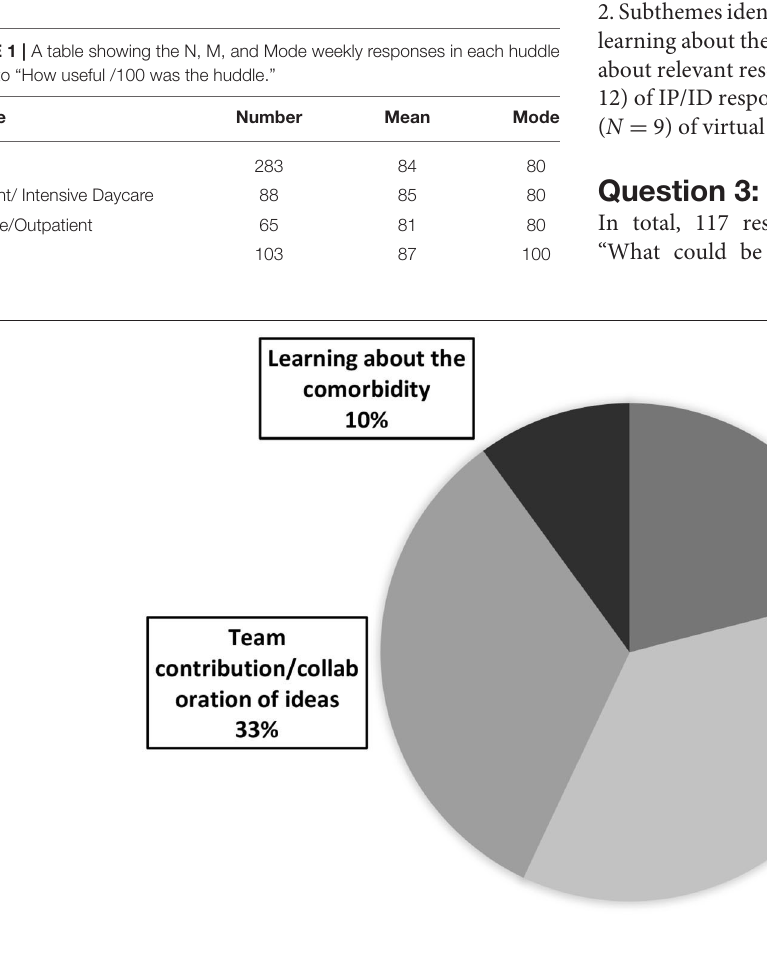
Frontiers in Psychiatry |